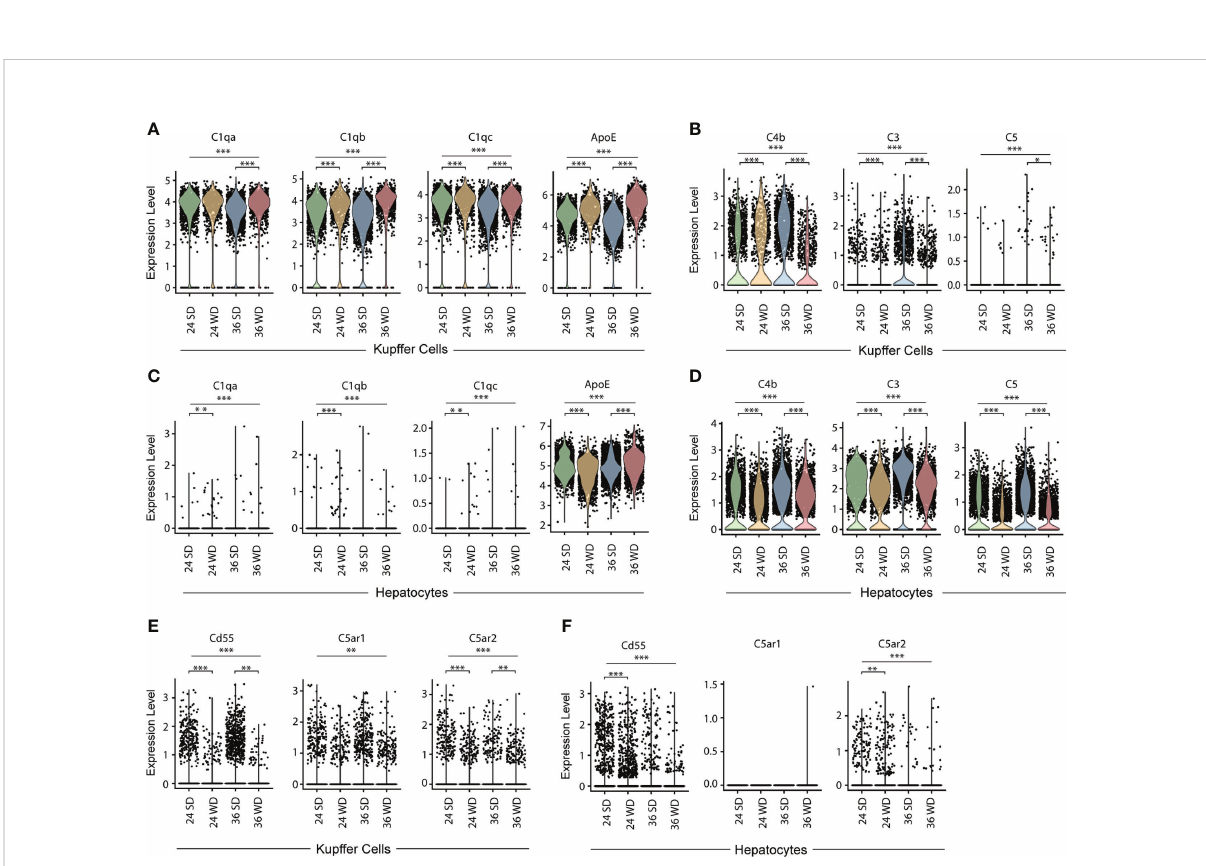
FIGURE 5 Transcript expression of C1q, ApoE and complement components in KCs and hepatocytes in healthy and diseased mouse livers. (A, B) Violin plots show C1qa, C1qb, C1qc, ApoE (A) and C4b, C3, and C5 (B) transcripts in KCs in standard diet-fed or WD-fed mice for 24 and 36 weeks. (C, D) Violin plots show C1qa, C1qb, C1qc, ApoE (C) and C4b, C3, and C5 (D) transcripts in hepatocytes in healthy and diseased mice. (E, F) Violin plots show CD55, C5AR1 and C5AR2 transcripts in KCs (E) and hepatocytes (F) in healthy and diseased mice. Each point represents one cell. Kruskal – Walli ’ s test with Dunn ’ s non-parametric all-pairs comparison test was adjusted by Benjamini Hochberg correction. *P < 0.05; **P < 0.01; ***P <